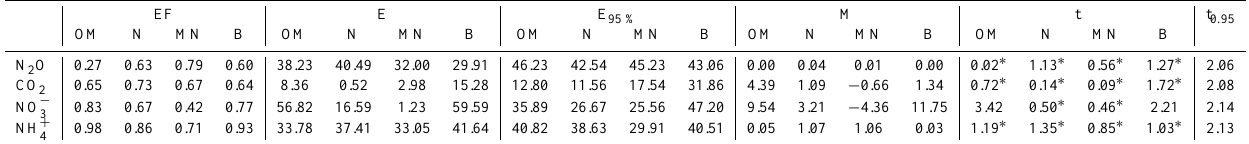
) for the top 10cm of the soil profile in summer maize fields. Fig. 5. Comparison of observed and modeled the nitrate (NO − 3 Table 2. The results of statistical metrics related to the performance of models in simulating the summer maize fields. EF E E 95 % M t